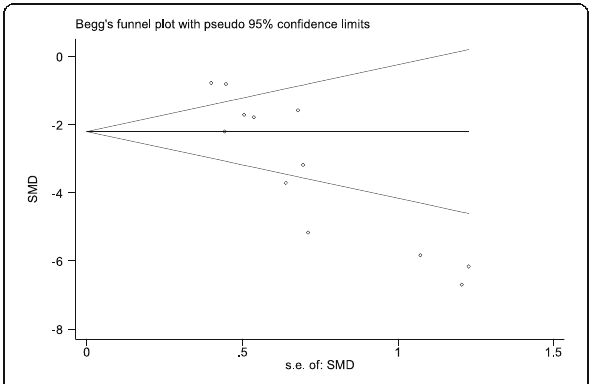
Fig. 3 Begg ’ s test for the outcome of escape latency